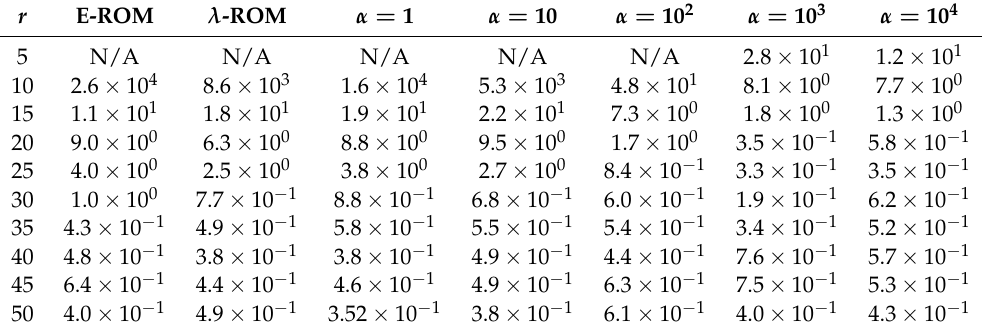
Table 3. Eulerian investigation, predictive regime: L 2 norm of the errors in the time-averaged streamfunction (22) for E-ROM (second column), λ -ROM (third column), and α -ROM for α = 1 (fourth column), α = 10 (fifth column), α = 10 2 (sixth column), α = 10 3 (seventh column), and α = 10 4 (eighth